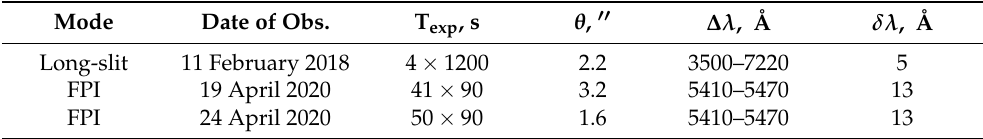
Table 1. Log of SCORPIO-2/6 m telescope observations. Mode Date of